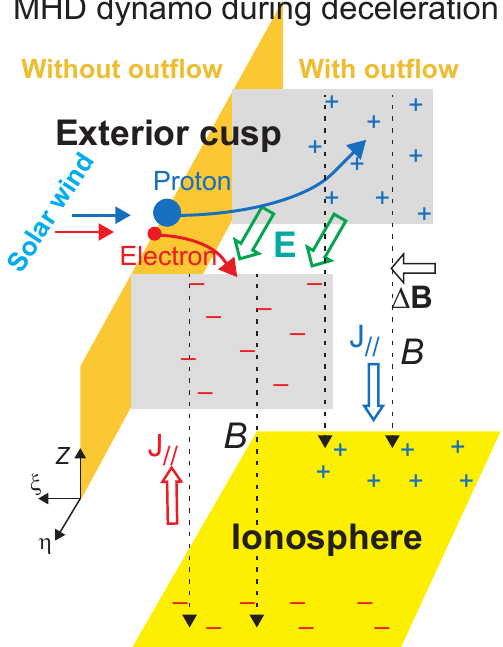
Figure 3. Illustration of azimuthal charge separation in a constant magnetic field B , when the solar wind inflow is decelerated by the start of mass loading with the outflowing ionospheric ions (the boundary of the start of the outflowing region is shown by an or- ange plane). The coordinates ξ and η are defined by the flow direc- tion at this boundary, and ξ is not necessarily aligned with the solar wind direction ( − X ) outside the magnetosphere when IMF points dawnward or duskward. The positive (negative) charges are always deflected opposite to (along) the motional electric field E of the flow, resulting in a dynamo current that causes a magnetic deviation ( (cid:49) B ). Because of the ionosphere, where charges can move along the electric field across the magnetic field, the accumulated charges form a current circuit through the field-aligned currents ( J // with blue and red arrows giving directions along B ) closing in the iono-